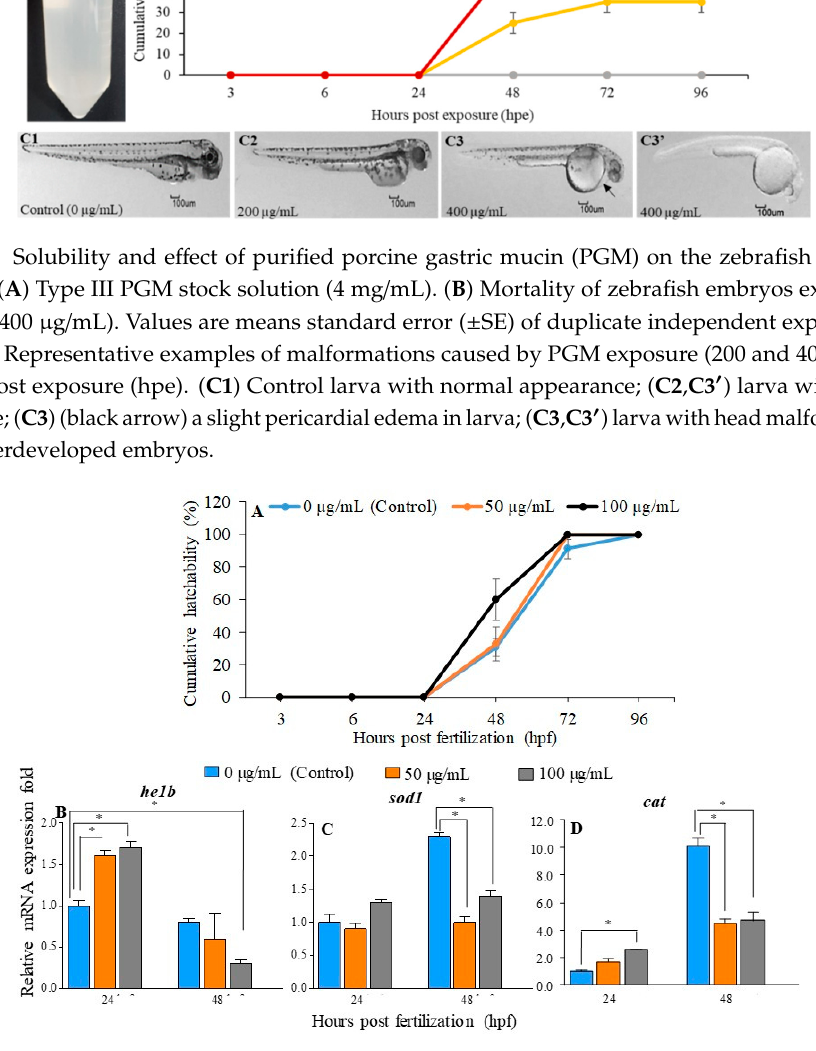
Figure 2. E ff ect of PGM on the hatching of zebrafish embryos. ( A ) Cumulative hatchability (%) of zebrafish embryos at 50 and 100 µ g / mL of PGM exposure. The relative mRNA expression of ( B ) he-1b , ( C ) sod1 , and ( D ) cat on hatching upon PGM exposure (50 and 100 µ g / mL). Values are mean standard error ( ± SE) of two independent experiments; asterisk marks are used to indicate the statistical significance compared to untreated control (two-way and one-way ANOVA, * p <